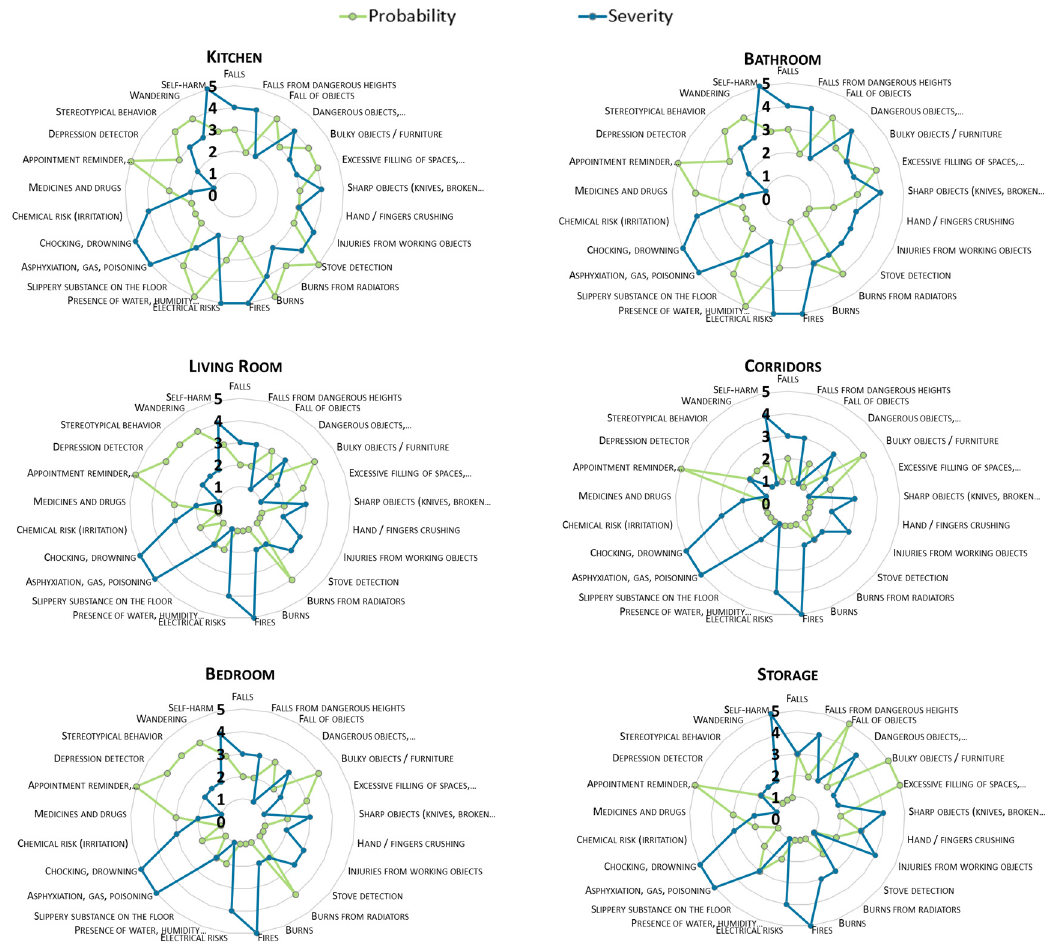
Figure A2. Accidental risks: probability and severity in the rooms of a typical living environment.